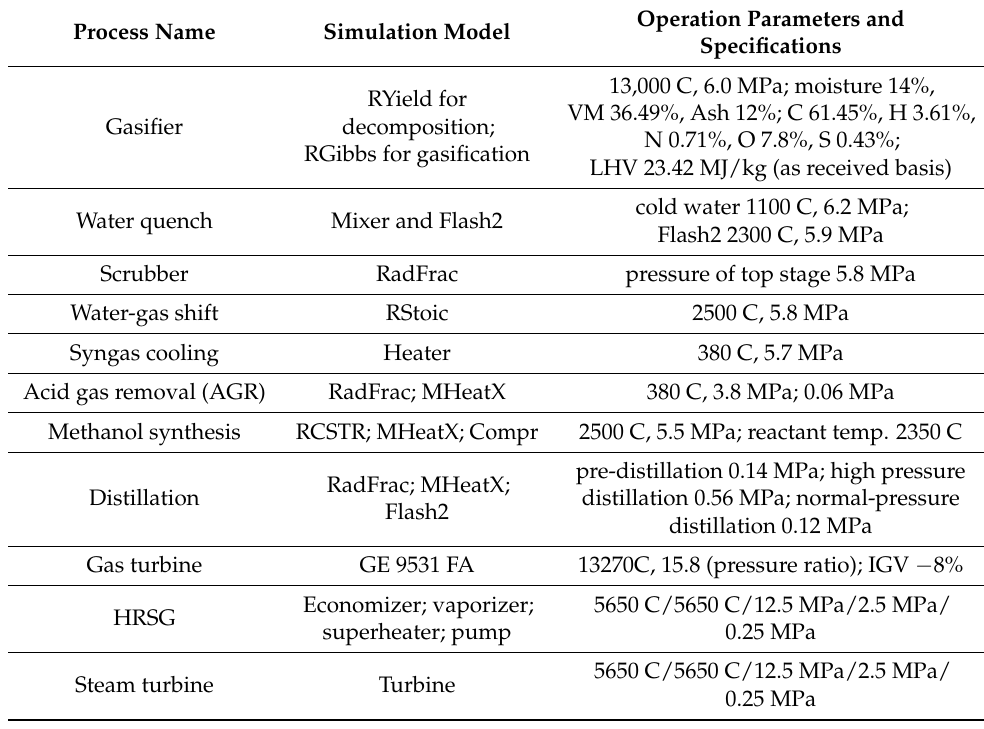
Table 1. Operating parameters and specifications of the